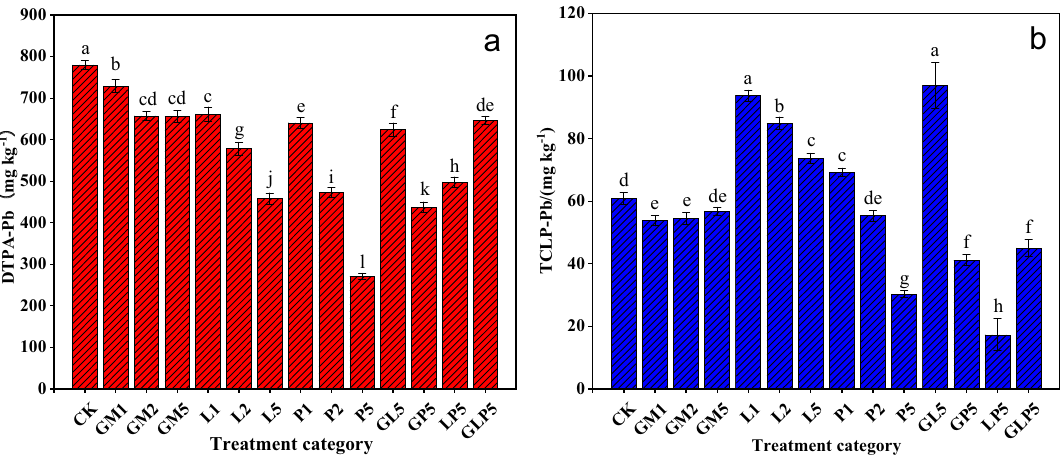
Figure 3. Content of DTPA-Pb and TCLP-Pb under different passivators (Origin 2019b). (CK: control check, GM: goat manure, L: Ca(OH) 2 , P: Ca(H 2 PO 4 )·2H 2 O, GL: goat manure + Ca(OH) 2 , GP: goat manure + Ca(H 2 PO 4 )·2H 2 O, LP: Ca(OH) 2 + Ca(H 2 PO 4 )·2H 2 O, GLP: goat manure + Ca(OH) 2 + Ca(H 2 PO 4 )·2H 2 O; 1, 2, 5 represents the proportion of